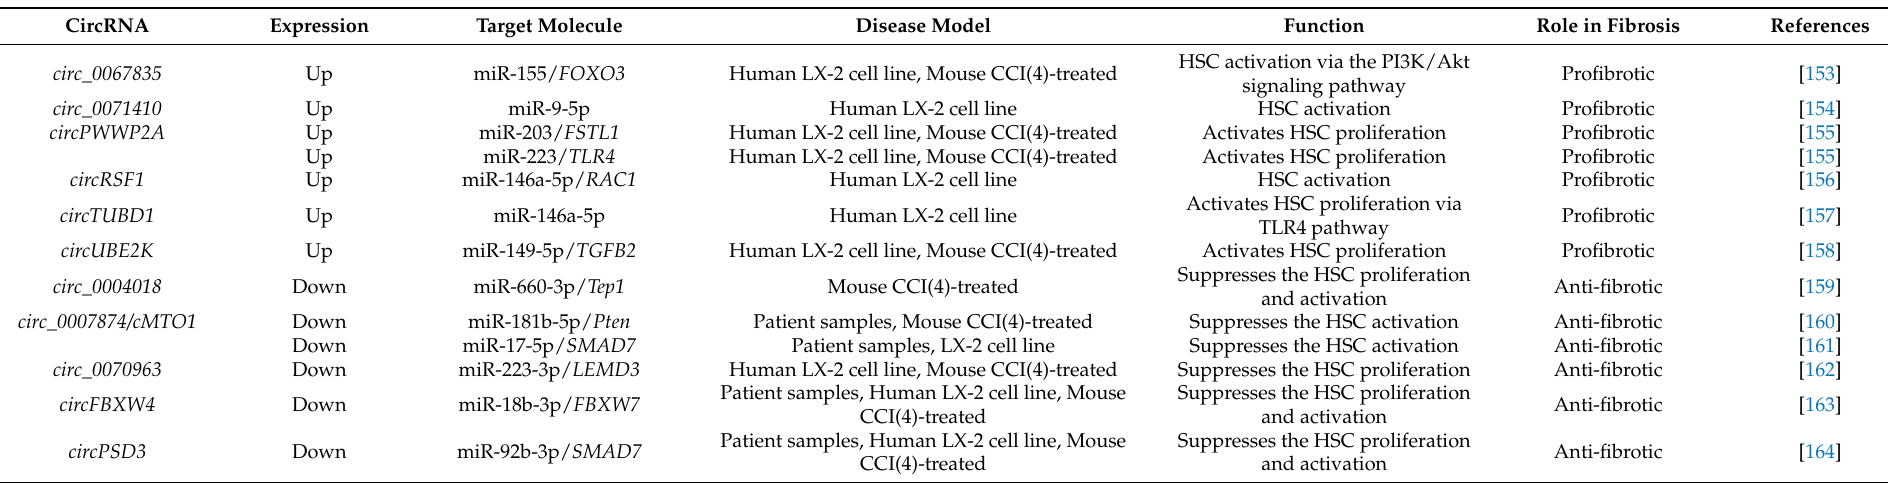
Table 3. Summary of circular RNA (circRNA) involved in hepatic stellate cells (HSC) activation in